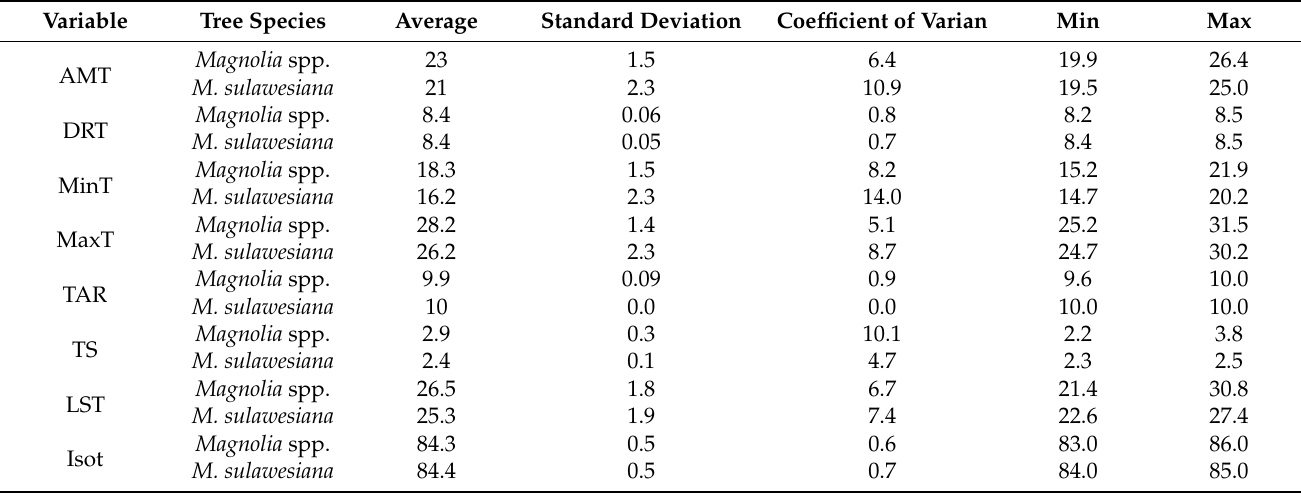
Table 4. Statistical descriptions for temperature